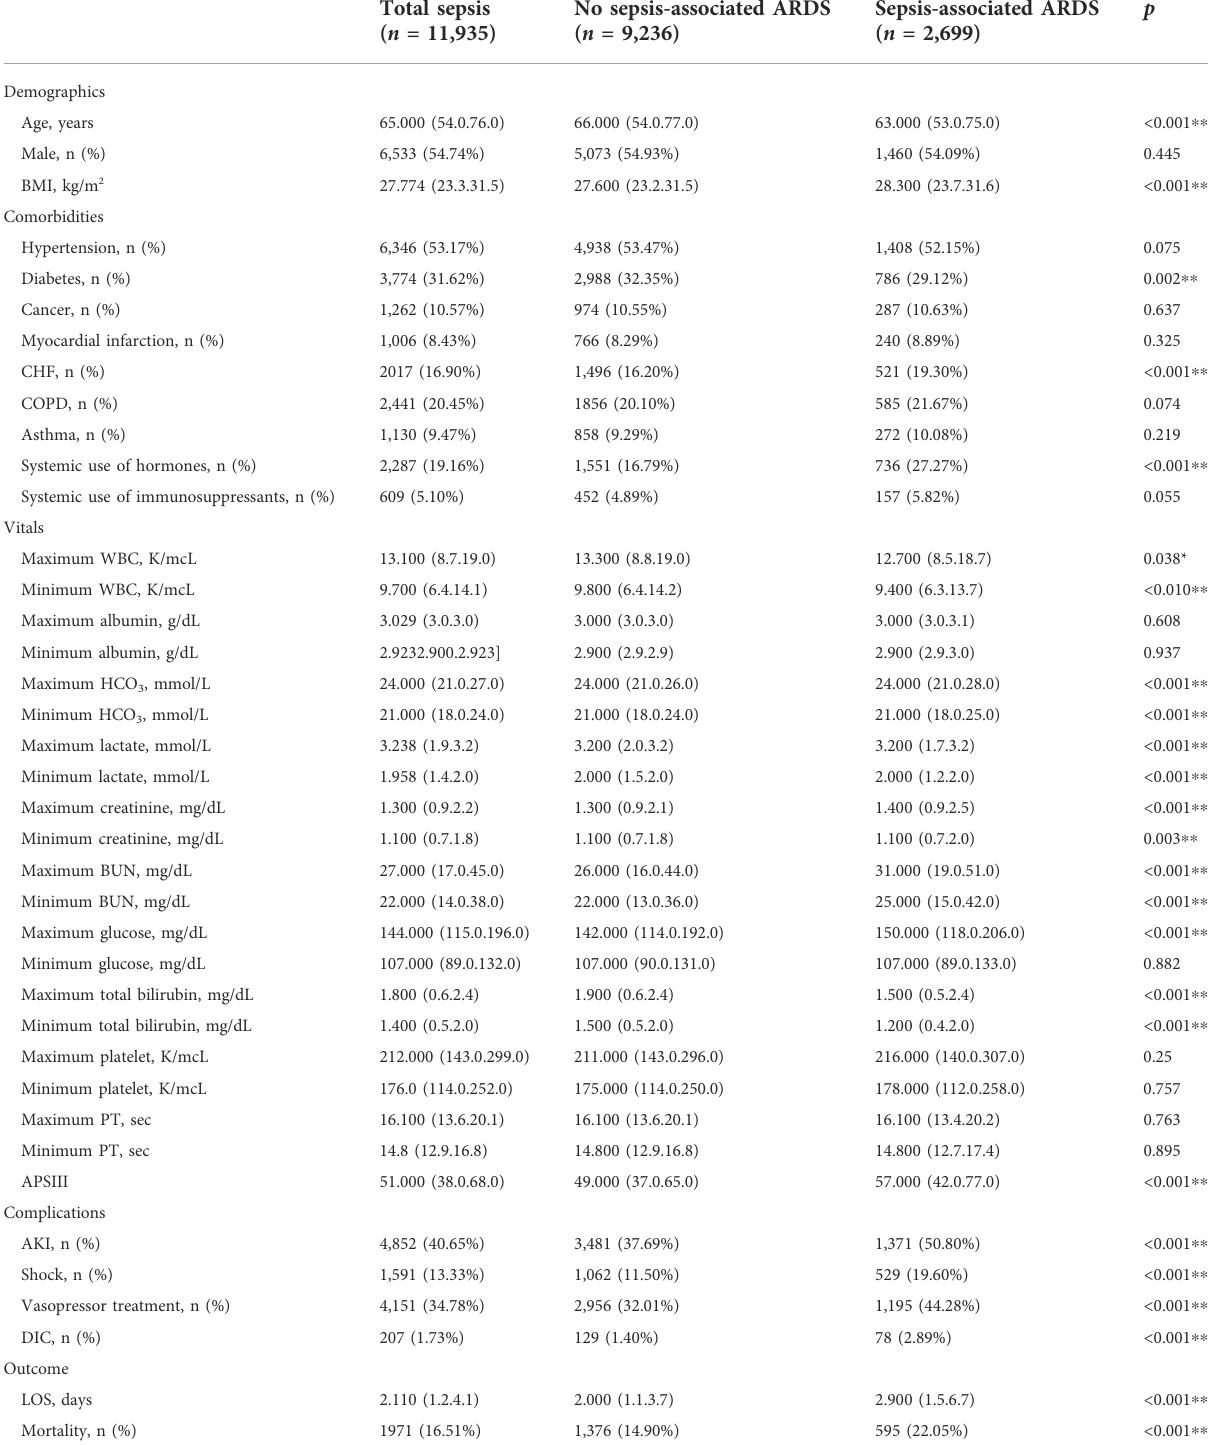
TABLE 2 Baseline demographic and clinical characteristics of patients from the MIMIC-IV